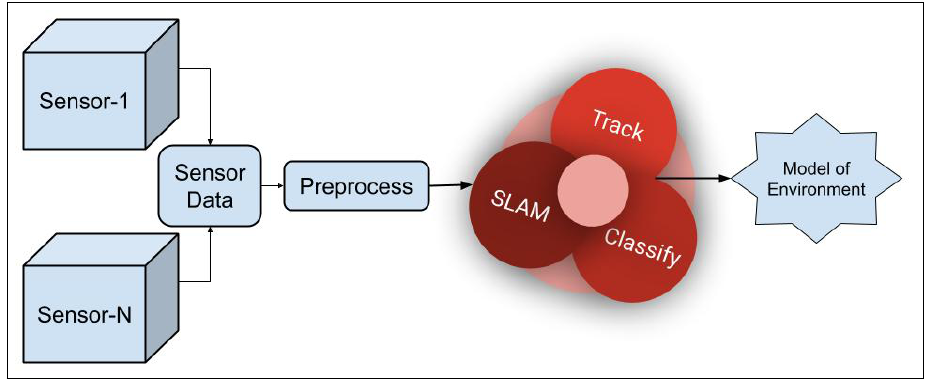
Figure 6. High-level perception